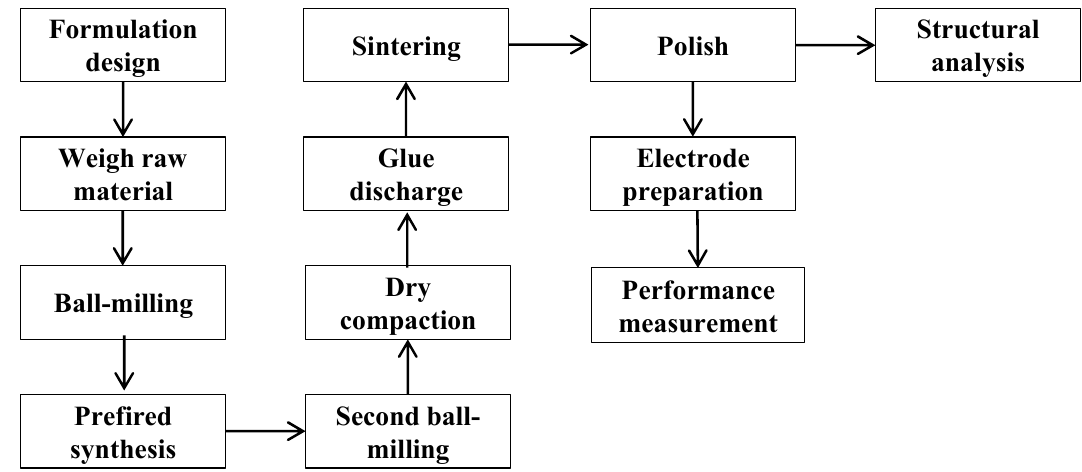
Figure 1. Process flow diagram of the NBT-100 x piezoelectric ceramics.